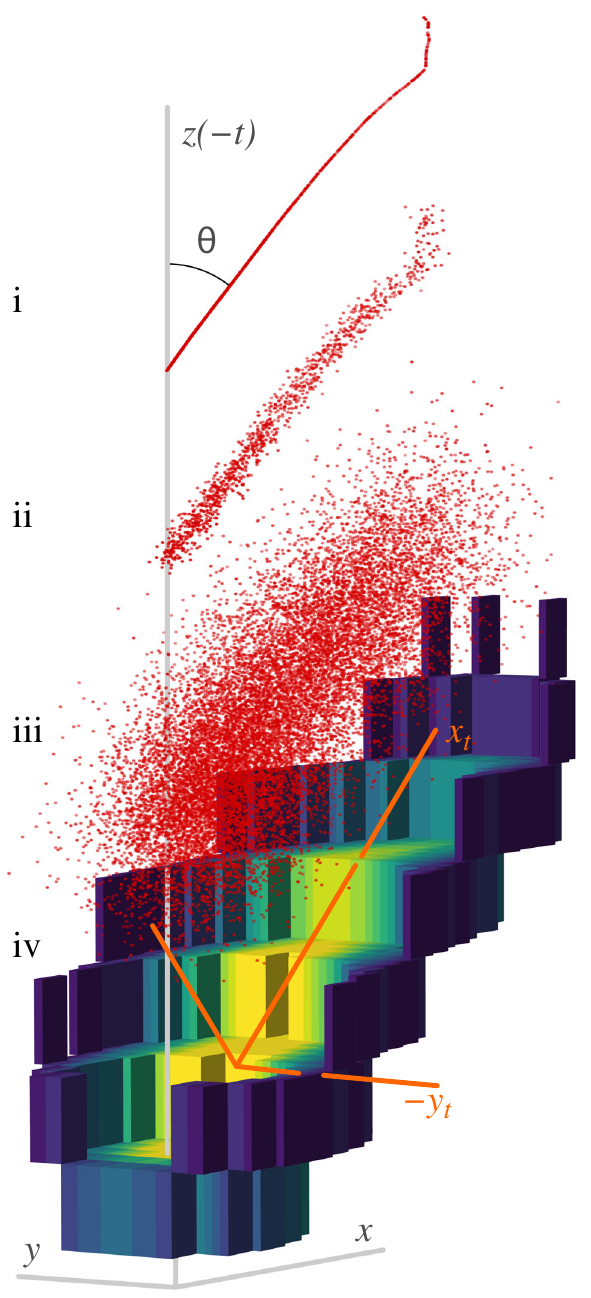
Fig. 2 The drift and diffusion model, illustrated. The primary track (i) consists of electrons produced by ionization along the track of the recoiling nucleus (one red dot represents 10 electrons). After drift (ii), theprimaryelectronshavediffusedin x − y andindependentlyin z .After amplification (iii), the number of electrons has been multiplied by the gain(herereducedbyafactorof100),withadditionaldispersioninboth x − y and z .Afterdigitization(iv),the2Dchargedensity(color/shade)is measuredinvoxelswith z positiondeterminedbytherelativethreshold- crossingtimeofeachpixel.Thechipcoordinatesystemisshowningray, and the track coordinate system in orange. The track vector points in the x t direction. The track shown is a 400 keV He recoil detected in a BEAST